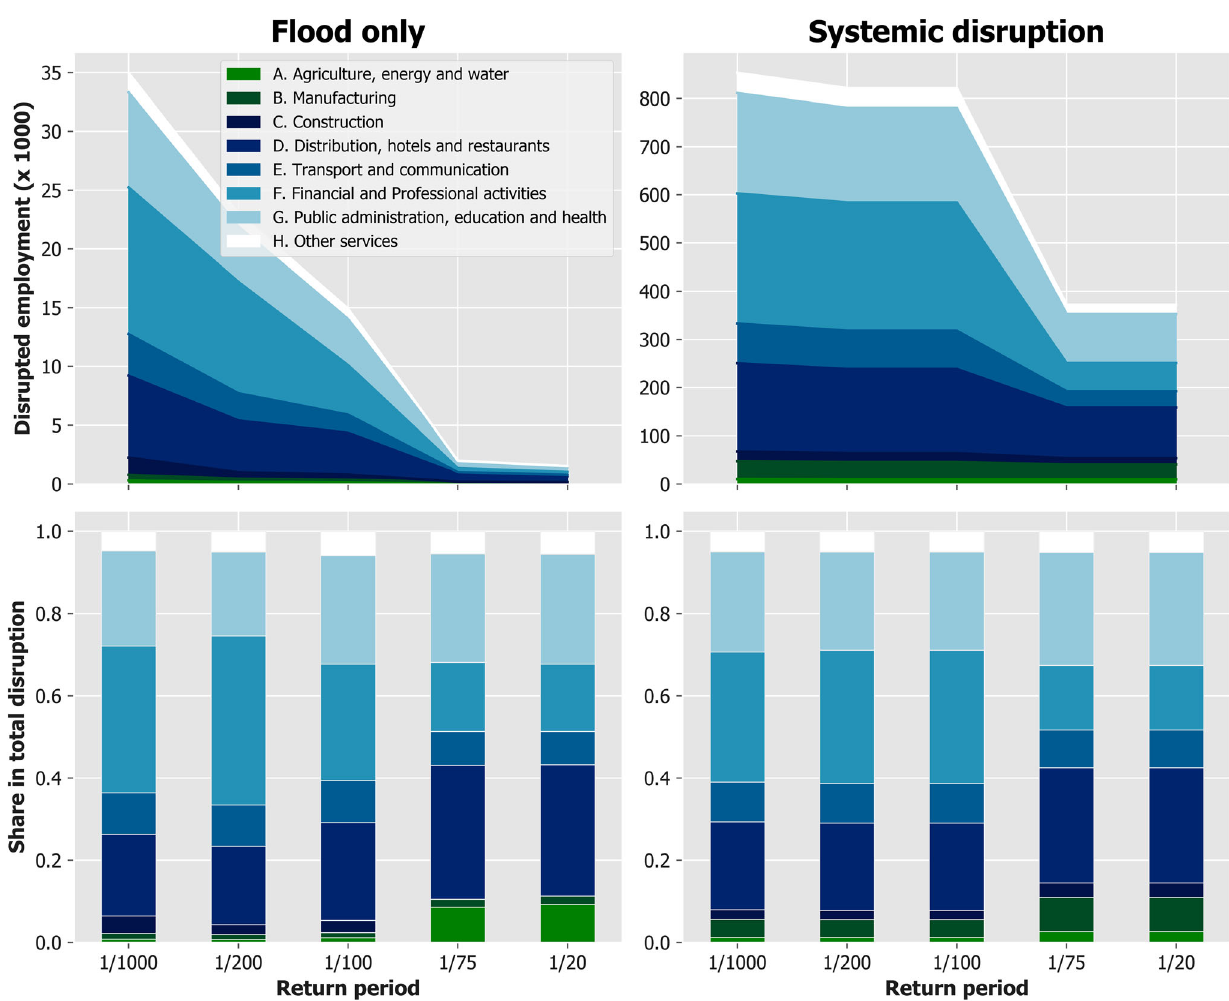
Fig. 6 Projected reduction in employment due to extreme flooding in the southeast of England. Disrupted employment per sector for a flood appears only in absolute terms (upper left panel) and in relative terms